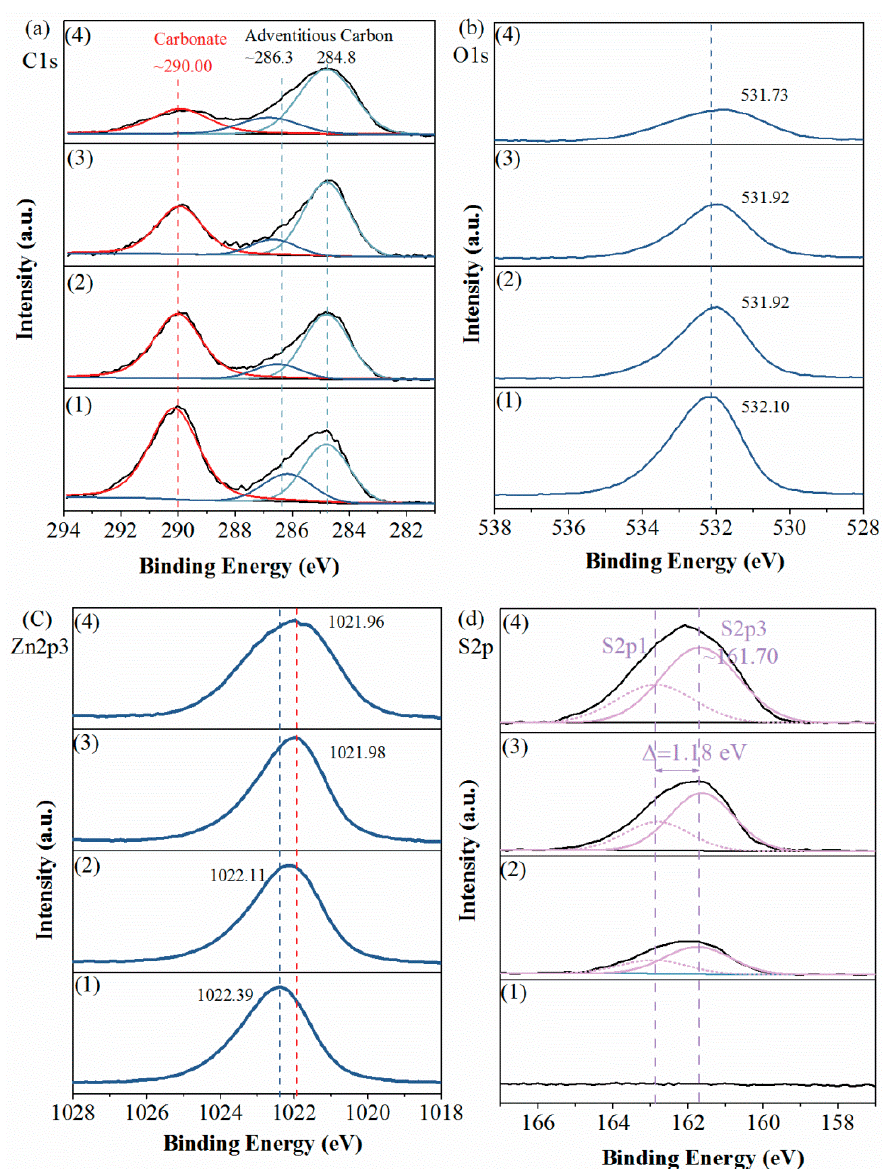
Figure 5. Detail-scans of ( a ) C1s, ( b ) O1s, ( c ) Zn2p3 and ( d ) S2p spectra of smithsonite treated with (1) 0, (2) 0.5 × 10 − 3 , (3) 2.5 × 10 − 3 and (4) 10 × 10 − 3 mol/L Na 2 S ⋅ 9H 2 O.